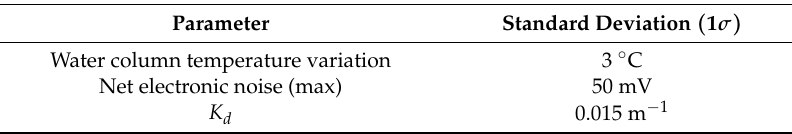
Table 1. Uncertainty parameters used in the Monte Carlo